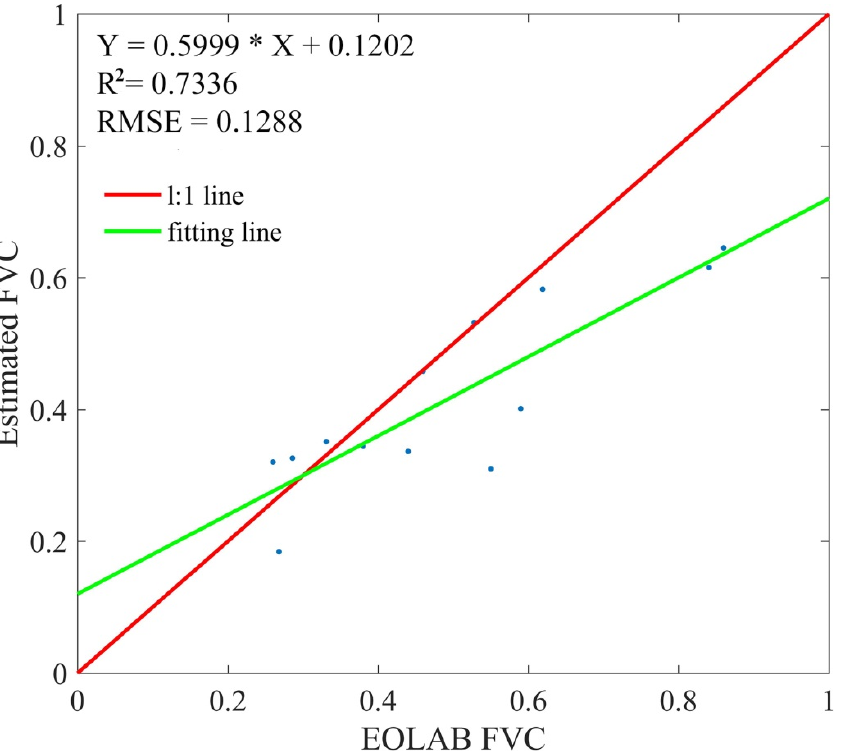
Figure 7. Scatter plot of the estimated FVC estimation by the proposed algorithm and the EOLAB reference FVC data. reference FVC